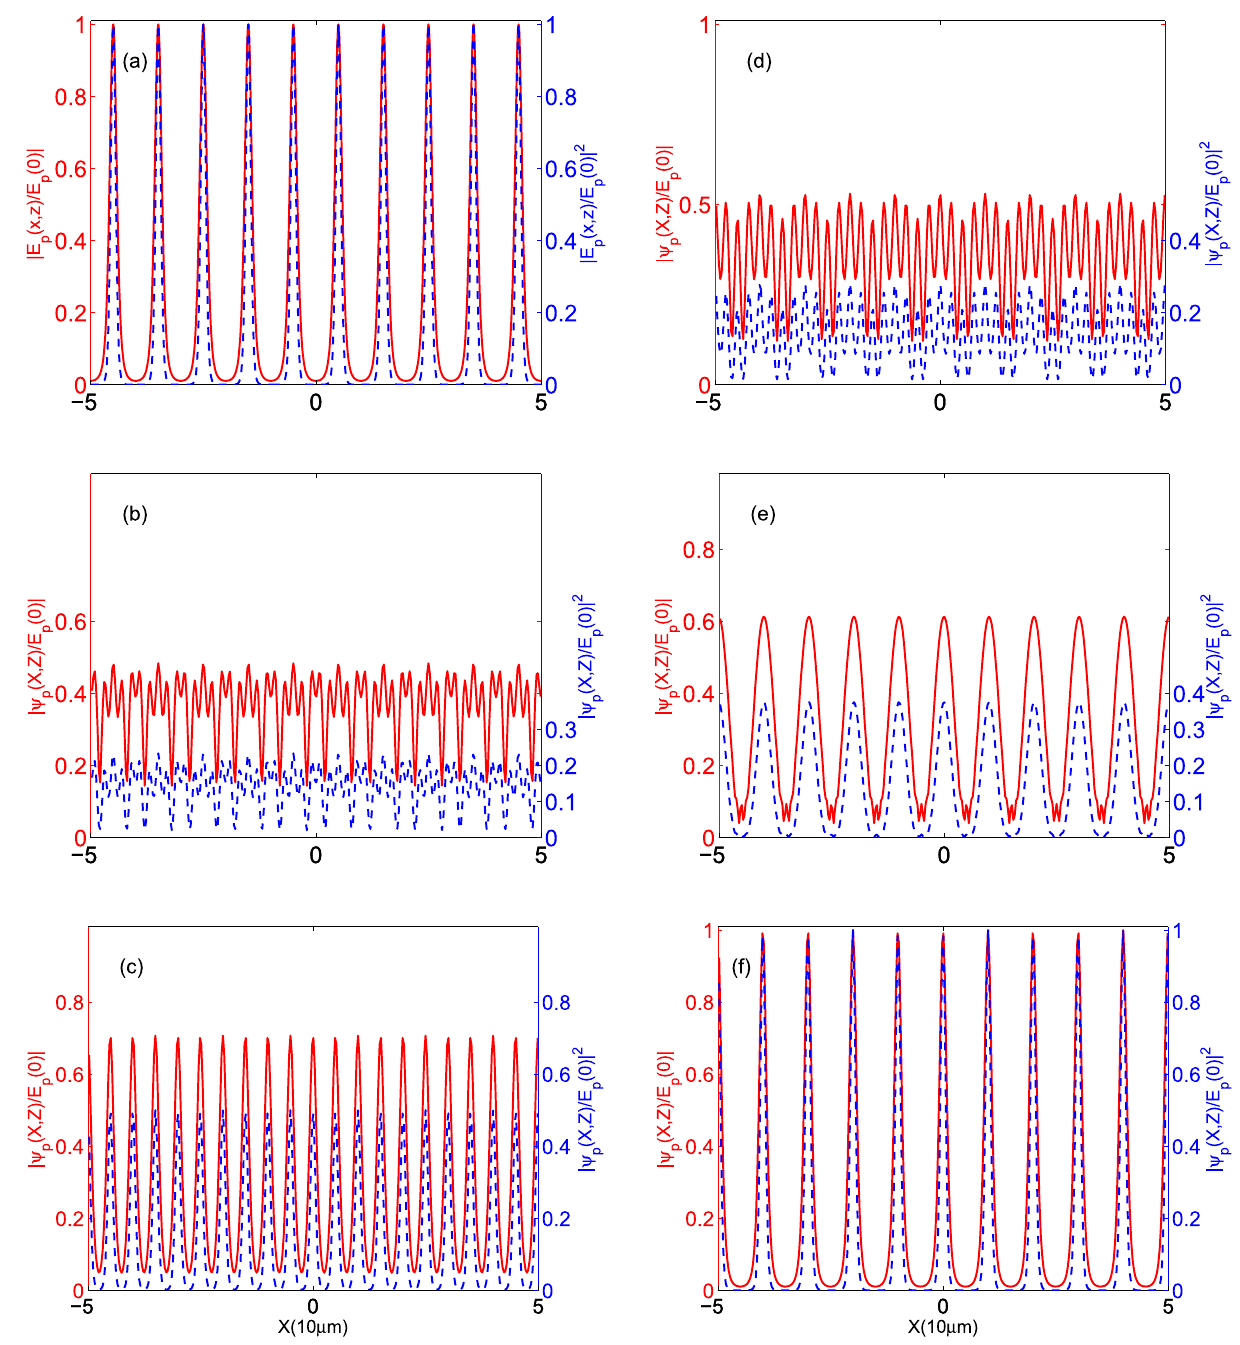
Figure 10. The profiles of ( a ) the output probe field at z = L and its diffracted field at ( b ) Z = Z T / 5 , ( c ) Z = Z T / 4 , ( d ) Z = 3 Z T / 8 , ( e ) Z = 9 Z T / 20 , and ( f ) Z = Z T / 2 under the same parameters of Fig. 9 except for T e = 0.5 Ŵ . Solid (dashed) curves with the left (right) vertical axis demonstrate the amplitude (intensity) of the field in all